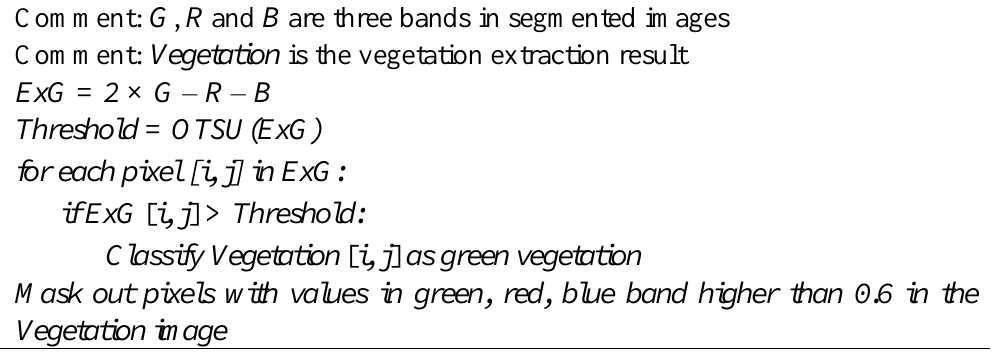
Algorithm 1. Spectral rules for vegetation classification based on segmented GSV